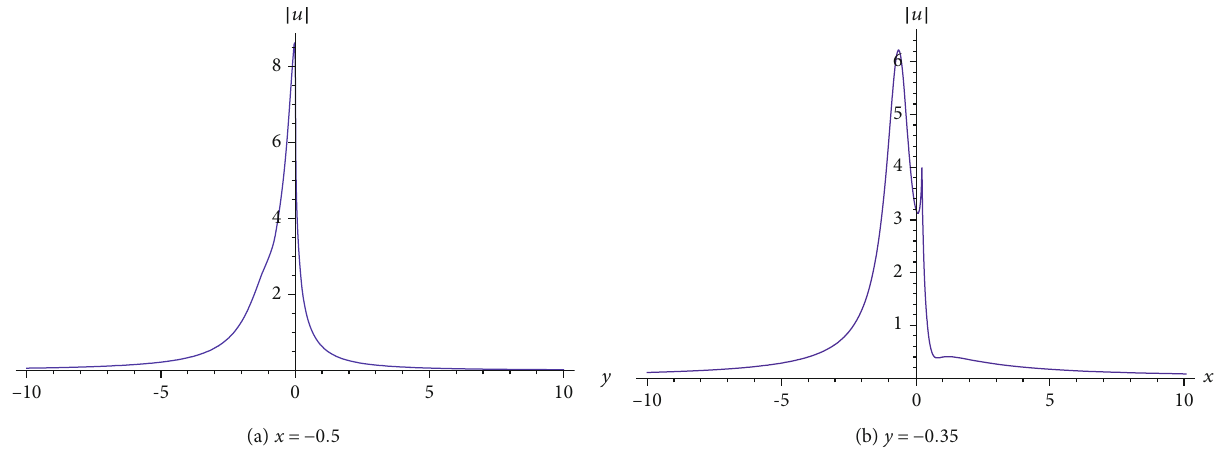
= − 0 : 6 , a = 0 : 8 , and t = 0 2 6